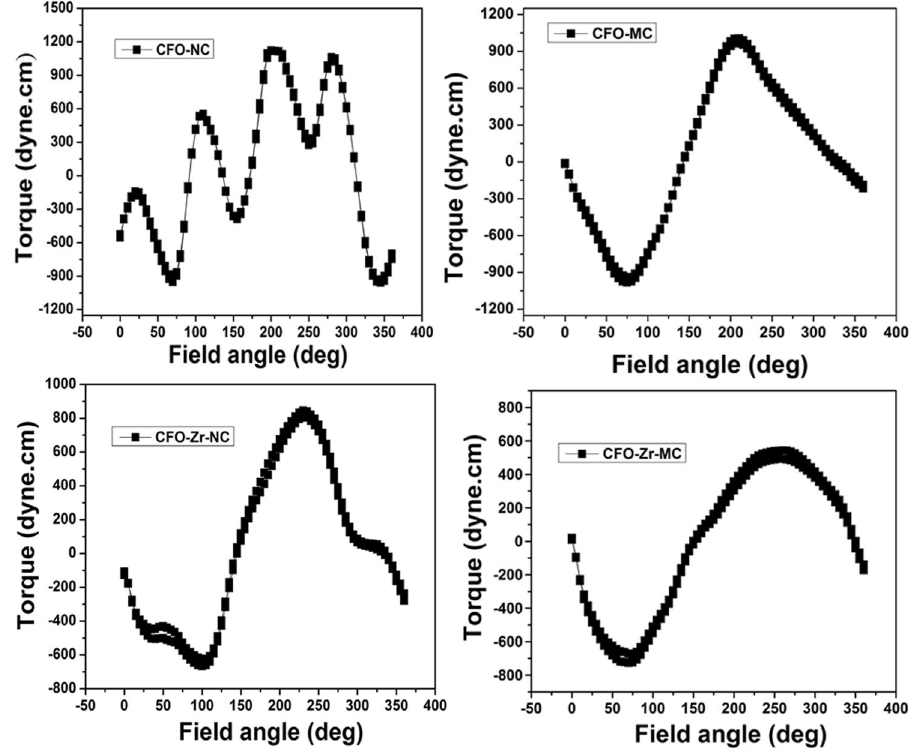
Figure 5. Torque curves of ( a ) x = 0 ( b ) x = 0.2 NC and MC